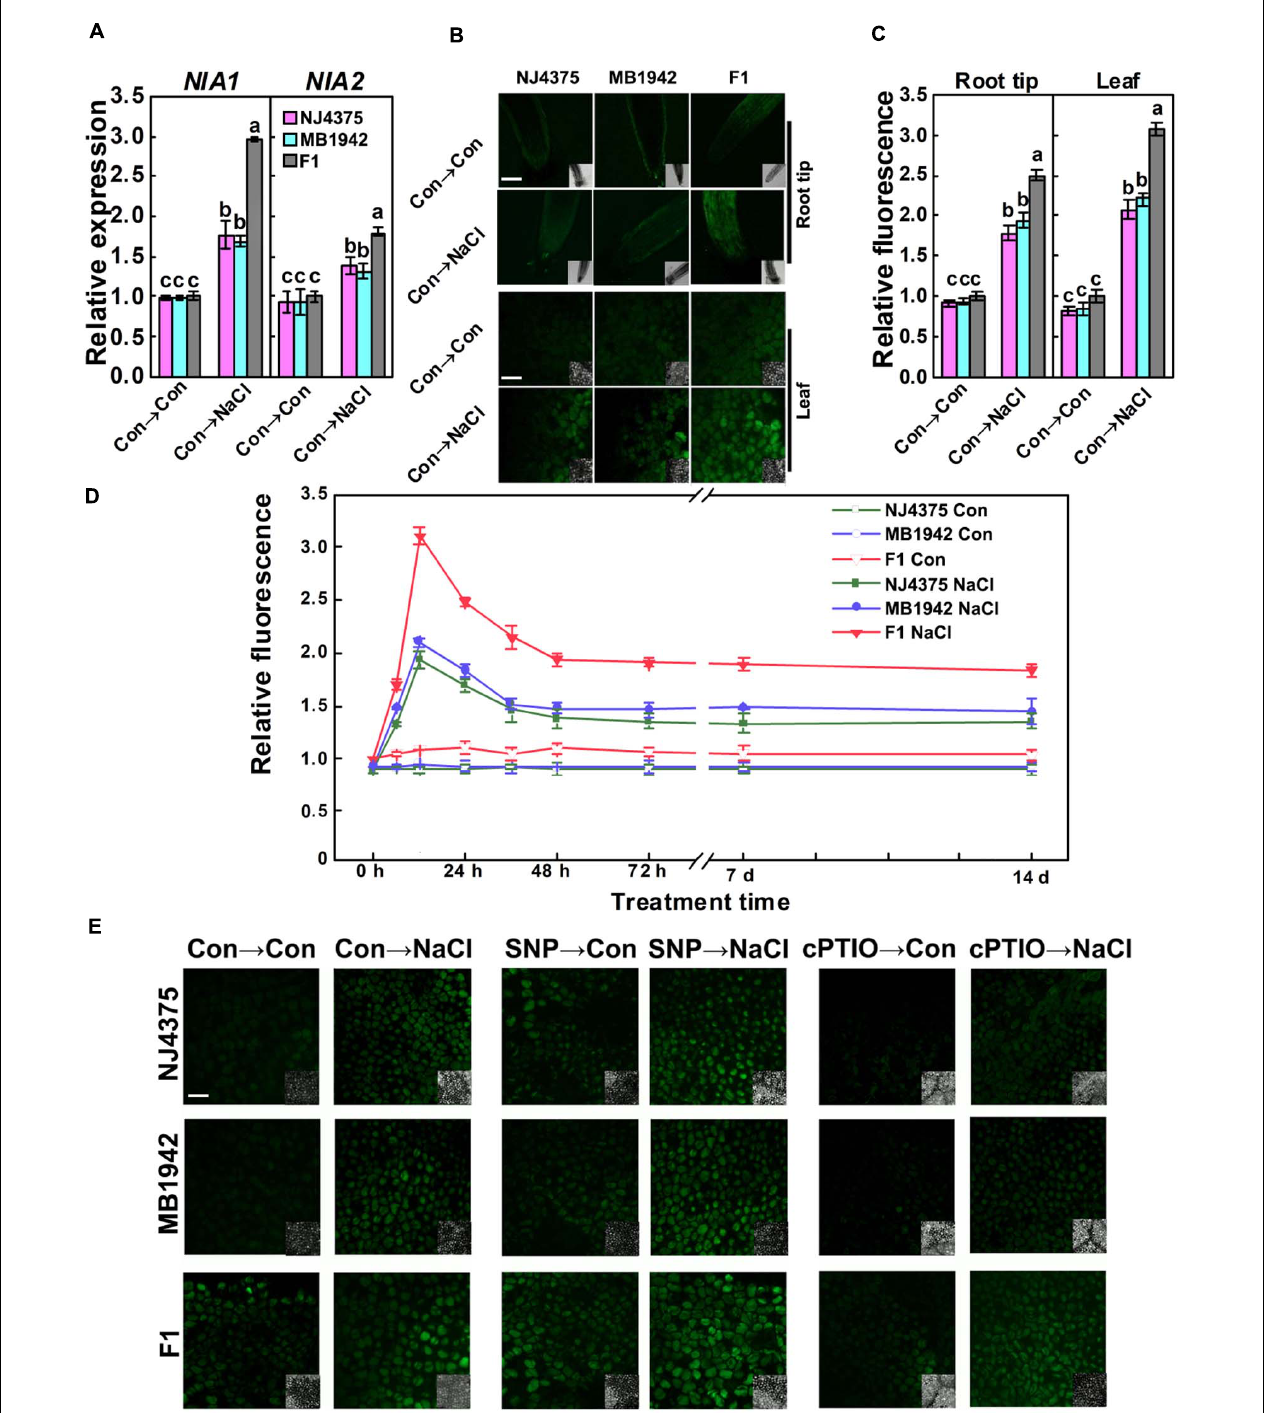
FIGURE 4 | Changes in nitric oxide (NO) homeostasis. (A) The gene expression levels of NIA1 and NIA2 in the leaves with or without stress for 6 h were analyzed by qPCR. (B) After treatment for 12 h, root tips and leaves were loaded with 4-amino-5-methylamino-2 (cid:48) ,7 (cid:48) -difluorofluorescein diacetate (DAF-FM DA) and detected by laser scanning confocal microscopy (LSCM). DAF-FM DA-dependent fluorescence densities according to panel (B) were given panel (C) . The time course of NO-related fluorescence in the leaves was also shown panel (D) . After treated for 12 h, the NO levels in the leaves were detected by LSCM (E) with or without SNP or cPTIO pre-treatment, respectively. Values are the means ± SD for three independent experiments. One-way ANOVA analyses were conducted according to Duncan’s multiple range test. Different letters denote significant differences at P < 0.05.